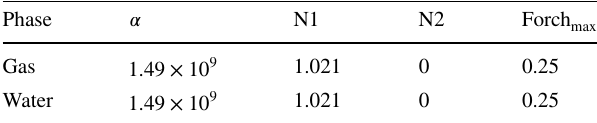
Table 2 Non-Darcy flow parameters